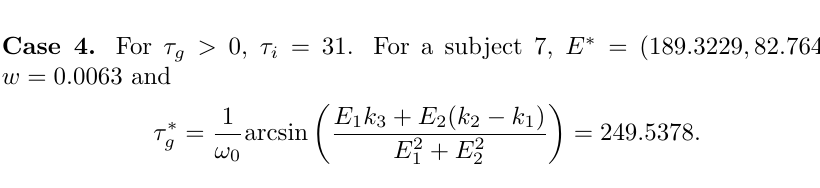
Figure 9. Glucose-insulin dynamics: dynamics and phase plain for τ = 300 > τ • = 228